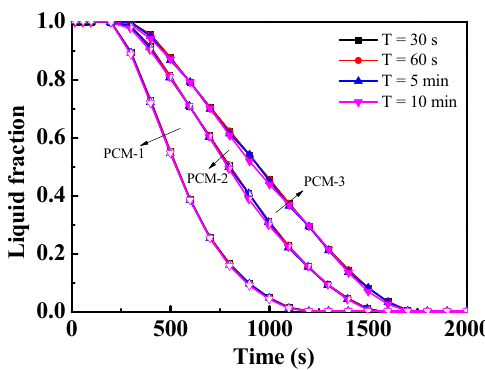
Figure 15. Liquid fractions of the m ‐ PCMs as a function of time at different periods ( T ) under the given inlet power condition (empty, half ‐ filled and filled symbols stand for liquid fractions of PCM ‐ 1, PCM ‐ 2 and PCM ‐ 3, respectively).